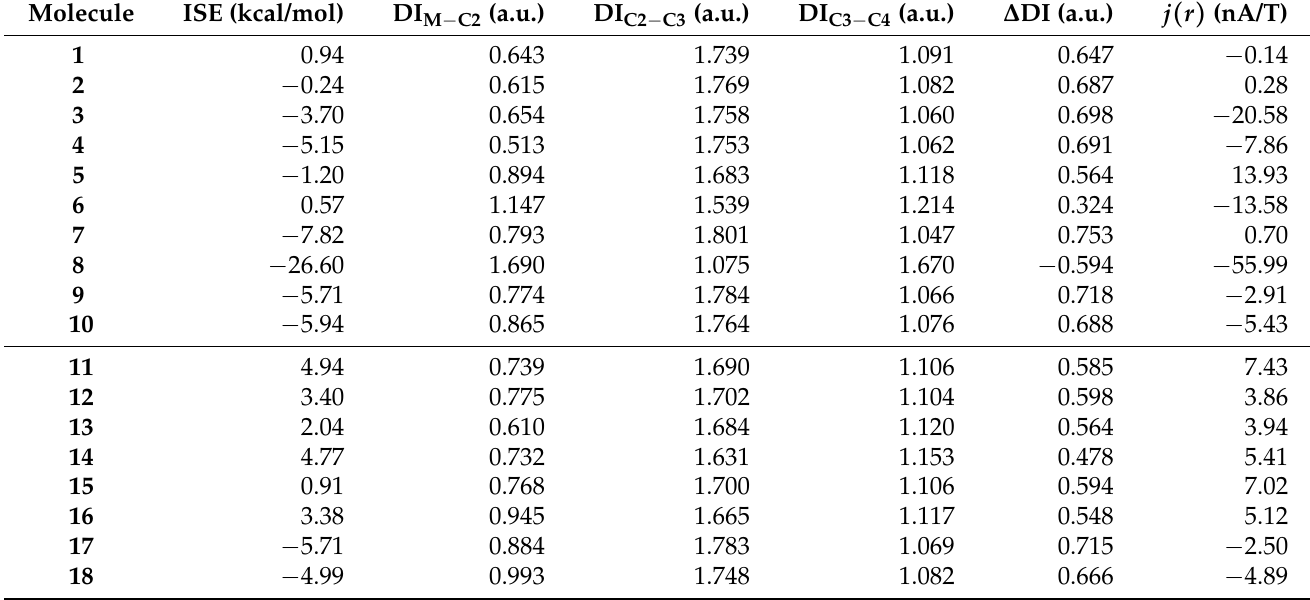
Table 2. ISE, DI and ring’s j ( r )